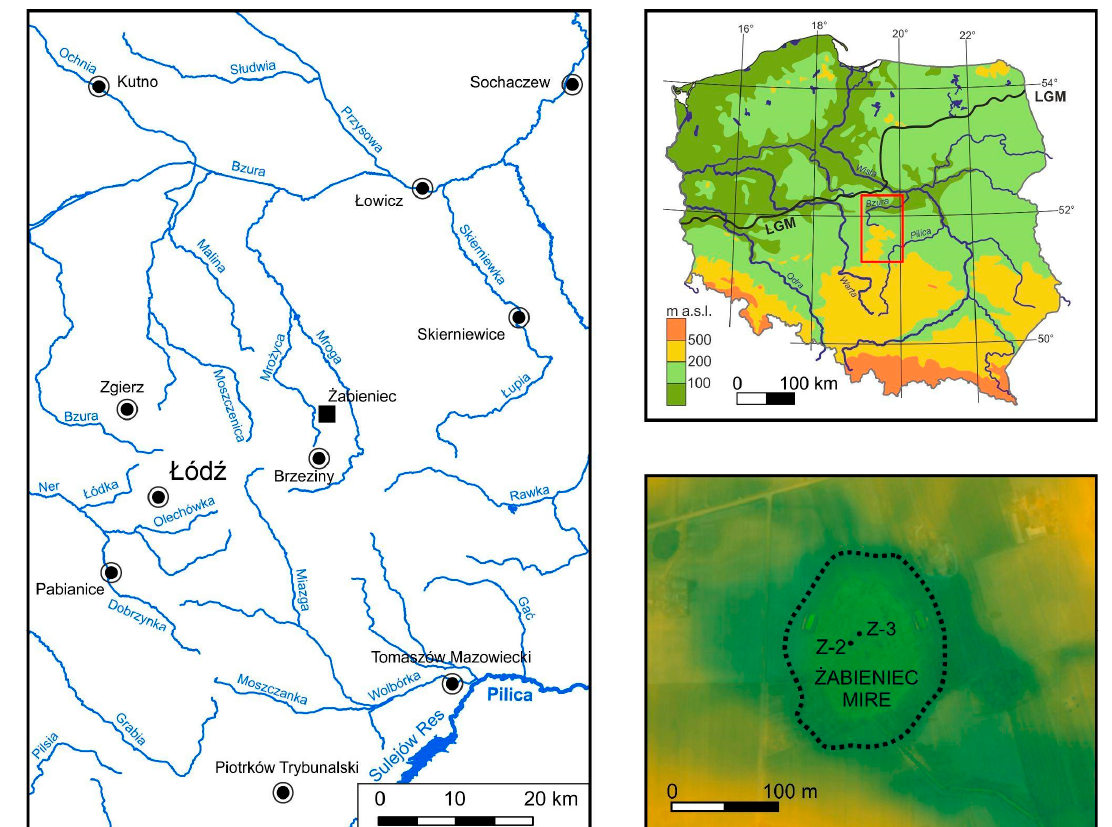
Figure 1. Locality of the study site ( Ż abieniec mire).